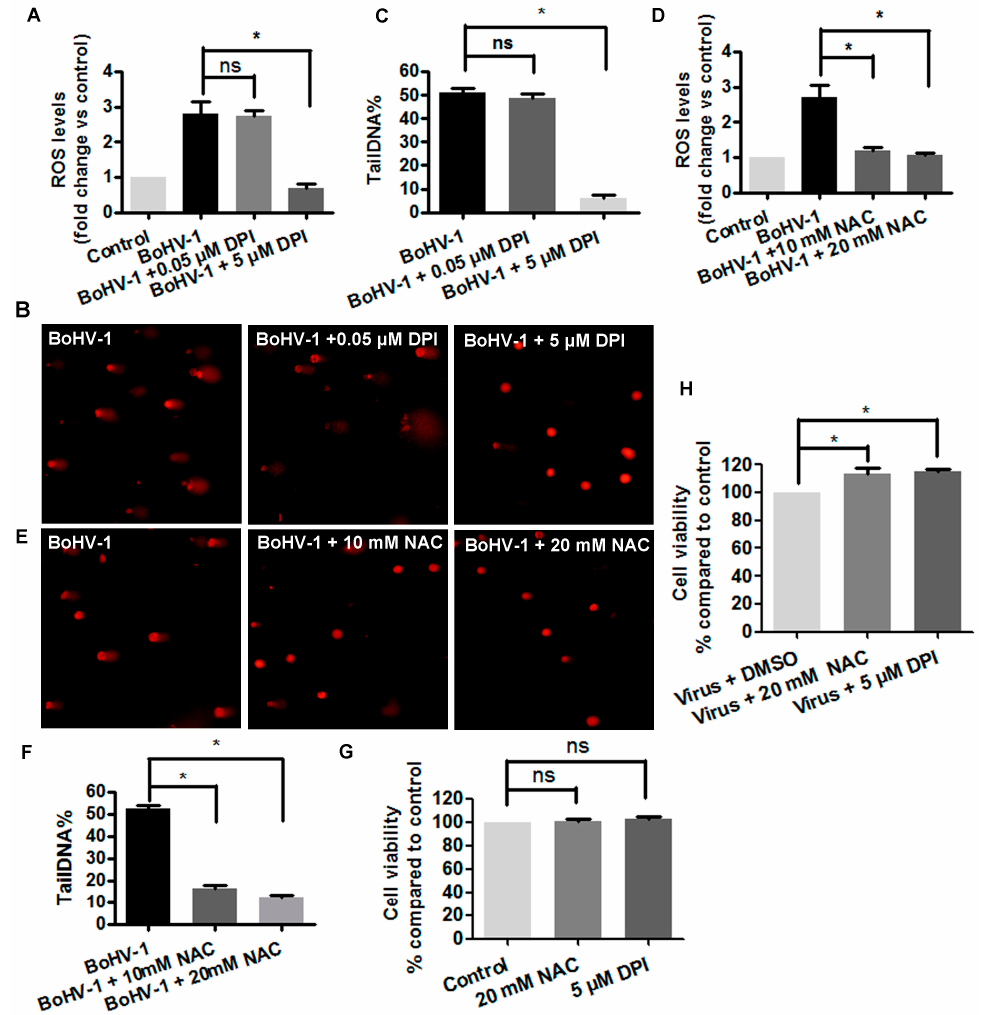
Figure 2. Reactive oxidative species (ROS) was involved in BoHV-1-induced DNA damage in MDBK cells. ( A , D ) MDBK cells were infected with BoHV-1 (MOI = 0.1) and treated with DPI ( A ) or NAC ( D ) at indicated concentrations. After infection for 24 h, cellular ROS levels were determined using H2DCFDA (5 μ M, 30 min) (Sigma-Aldrich, St. Louis, MO, USA) and quantitatively analyzed using software Image-pro Plus 6. *, significant differences ( P < 0.05), as determined by a Student t test. ( B , E ) MDBK cells were infected with BoHV-1 (MOI = 0.1), and treated with DPI ( B ) or NAC ( E ) at indicated